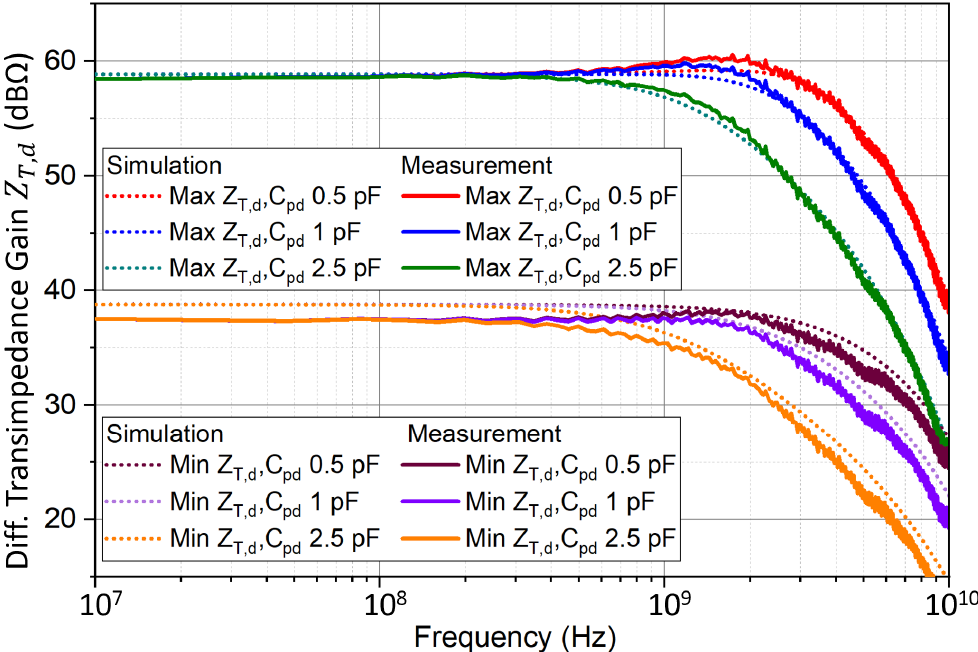
Figure 11. Simulated and measured transimpedance gain of the TIA with range of 𝐶